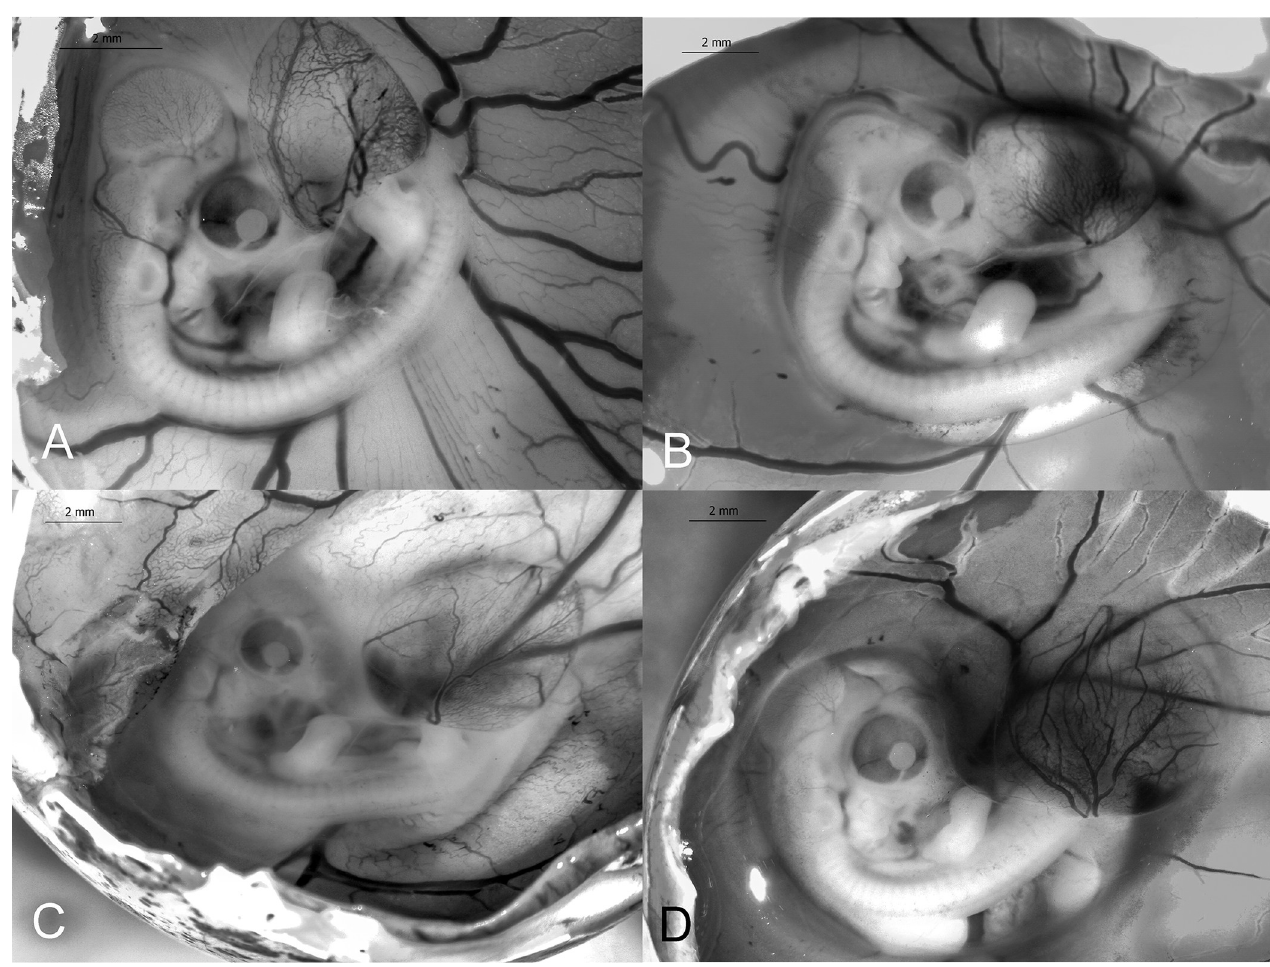
Fig 7. Stages 23–26 (114–144 h) of the California valley quail’s embryological stages of development. (A) Stage 23, anterior and posterior contours of limb- buds run parallel. (B) Stage 24, limbs have lengthened and are longer than wide. (C) Stage 25, all visceral protuberances have fused together and flattened. (D) Stage 26, wings bent at elbow and knee joints